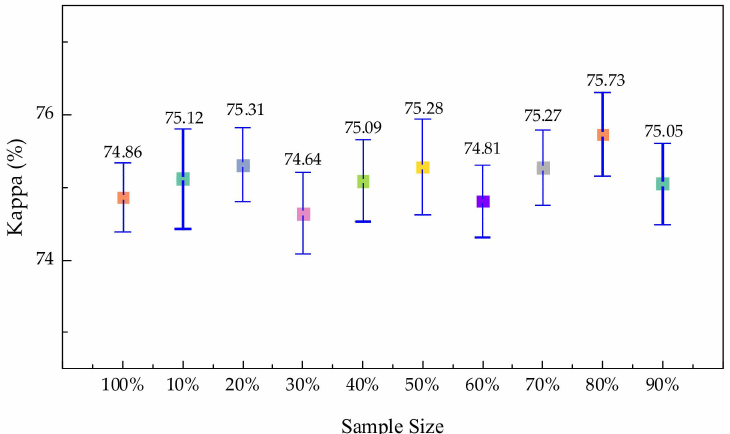
Figure 11. The Kappa and confidence intervals of SVM classifier after NKMNF with different proportion sample sizes (number of features = 45) in Xiong’an.